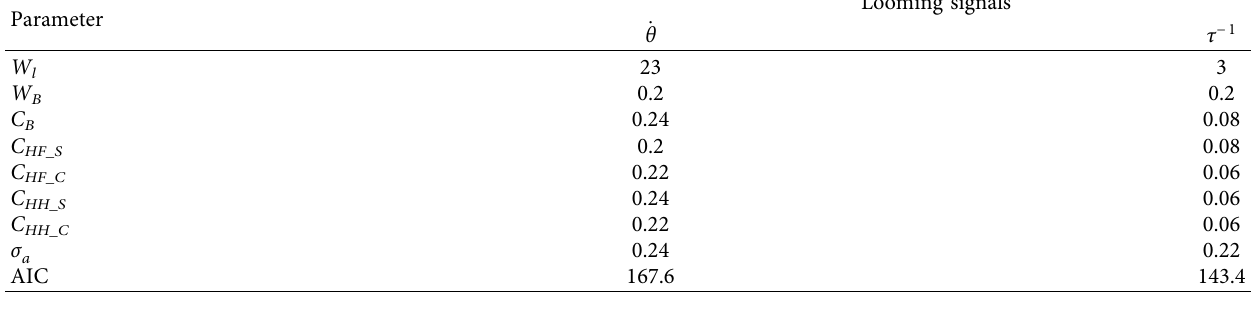
Table 4: Best parameterisation for accumulator model of brake response time using _ θ and τ − 1 , respectively.